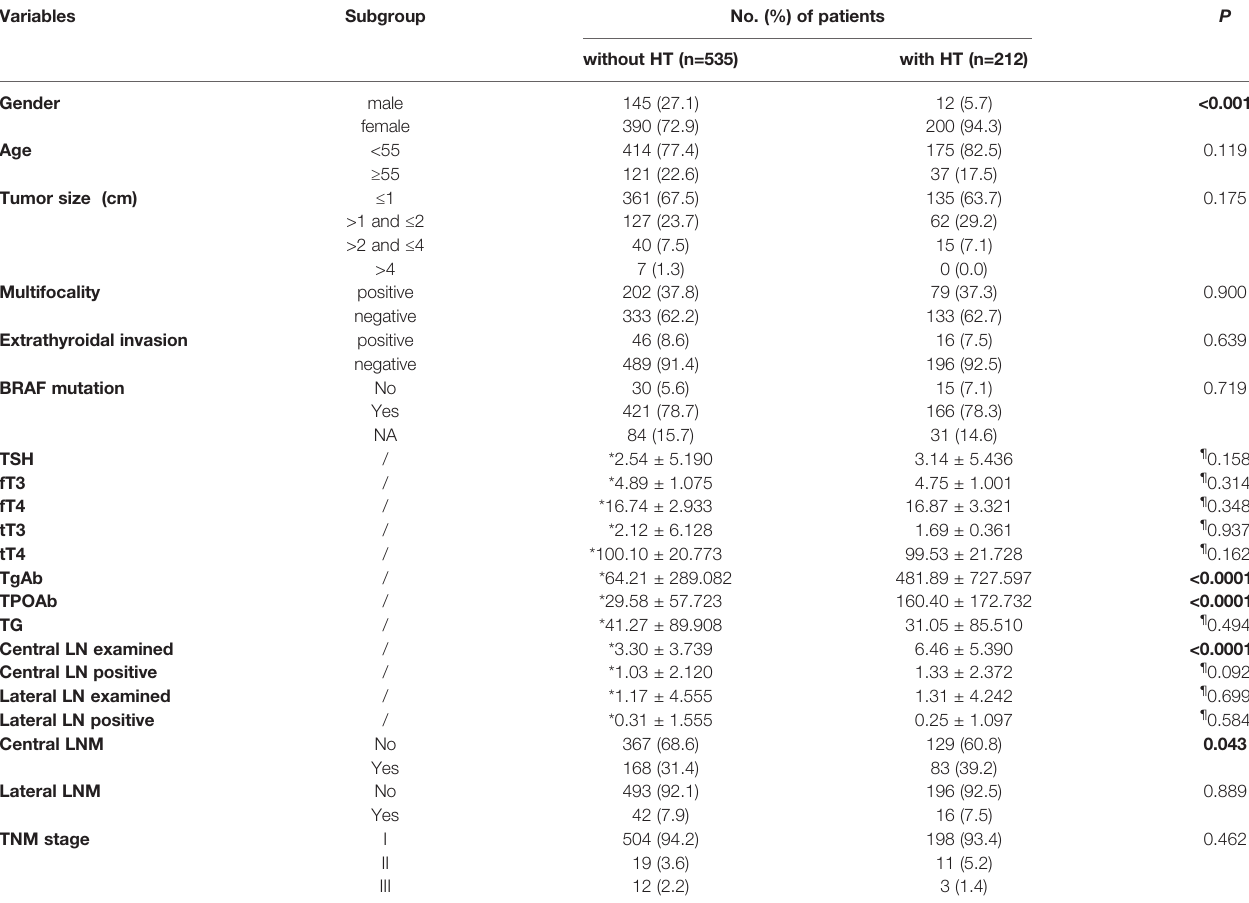
TABLE 2 | Clinicopathological features of 747 PTC patients with HT or without HT in the training cohort.